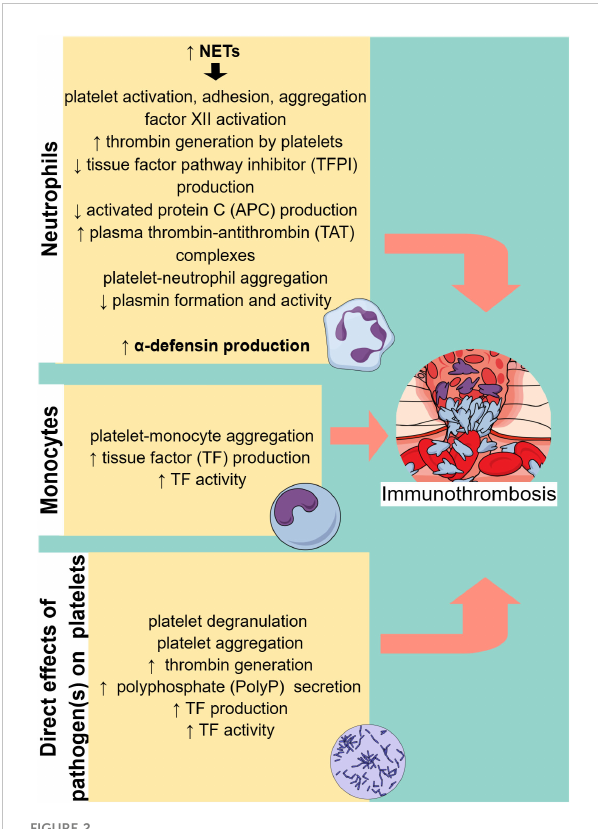
FIGURE 2 Cell-speci fi c immunothrombosis mechanisms. Neutrophils and monocytes can induce thrombosis through speci fi c mechanisms, while pathogens can directly activate platelets, leading to thrombosis. NETs, neutrophil extracellular traps. ↑ (arrow pointing up) means increased. ↓ (arrow pointing down) means